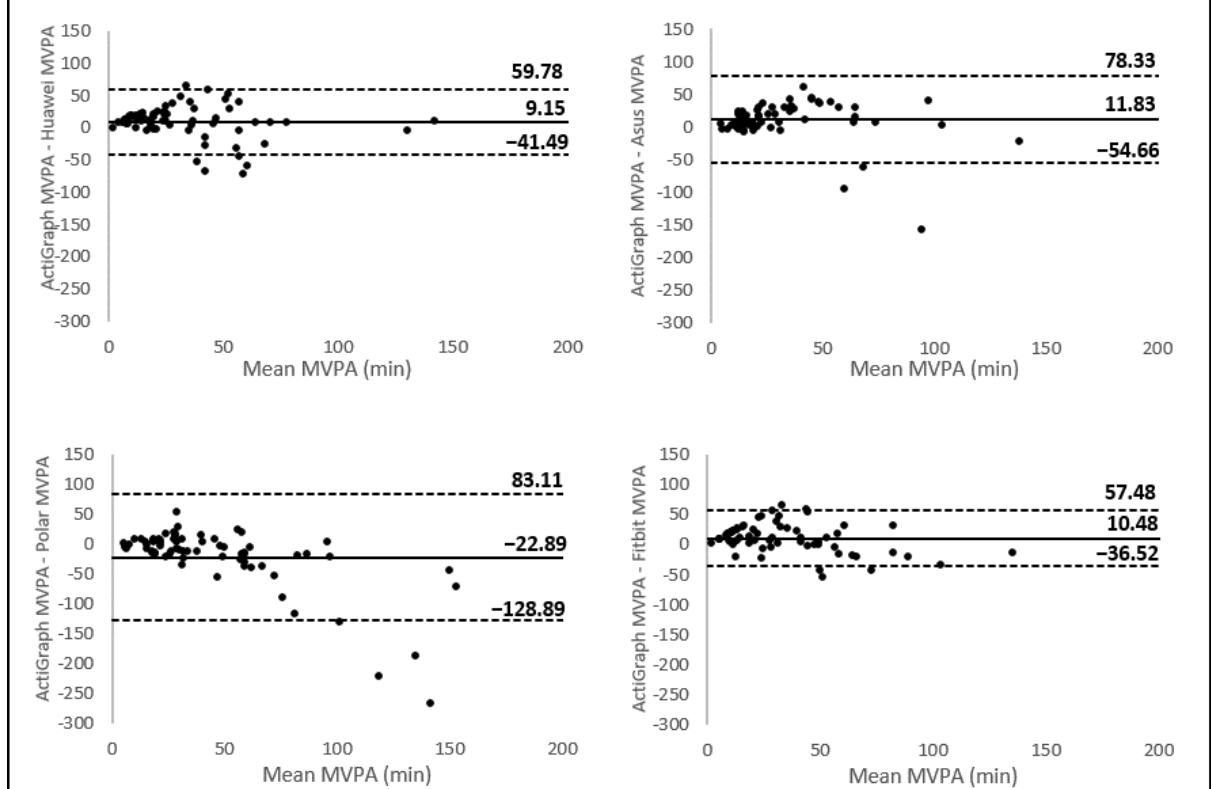
Figure 3. Bland-Altman plots of the consumer-level devices. The middle line shows the mean difference (Positive values indicate an underestimation of the consumer-level device and negative values indicate an overestimation) between the measurements of moderate-to-vigorous physical activity of the device and the ActiGraph, and the dashed lines indicate the limits of agreement (1.96 × SD of the difference scores). MVPA: moderate to vigorous physical activity.